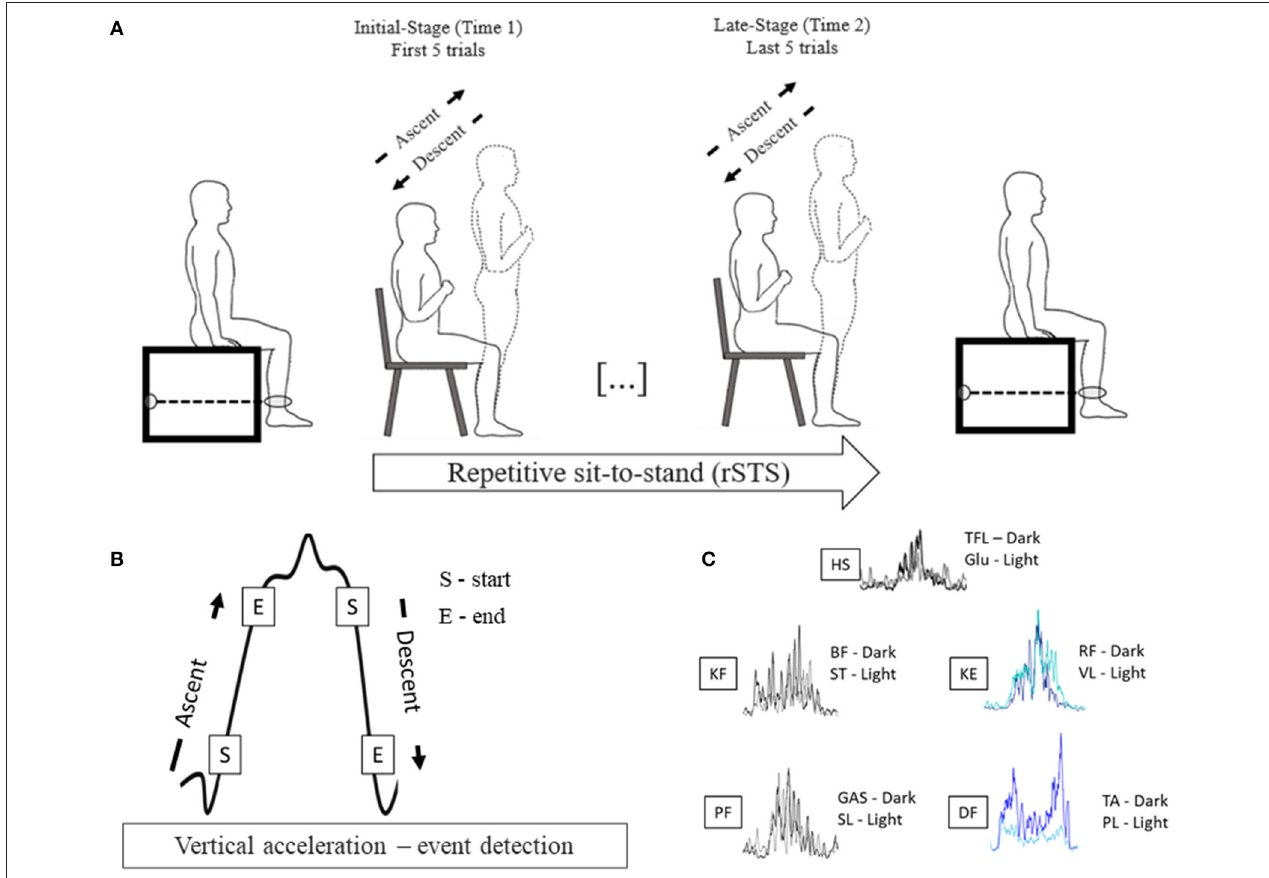
FIGURE 1 | (A) Experimental design; (B) Vertical acceleration profile of a sit-to-stand bout to exemplify the events used to detect the start and end and determine the sit-to-stand phases; (C) Filtered and rectified EMG of one STS bout of one participant showing similar temporal activation for pooling proposes.